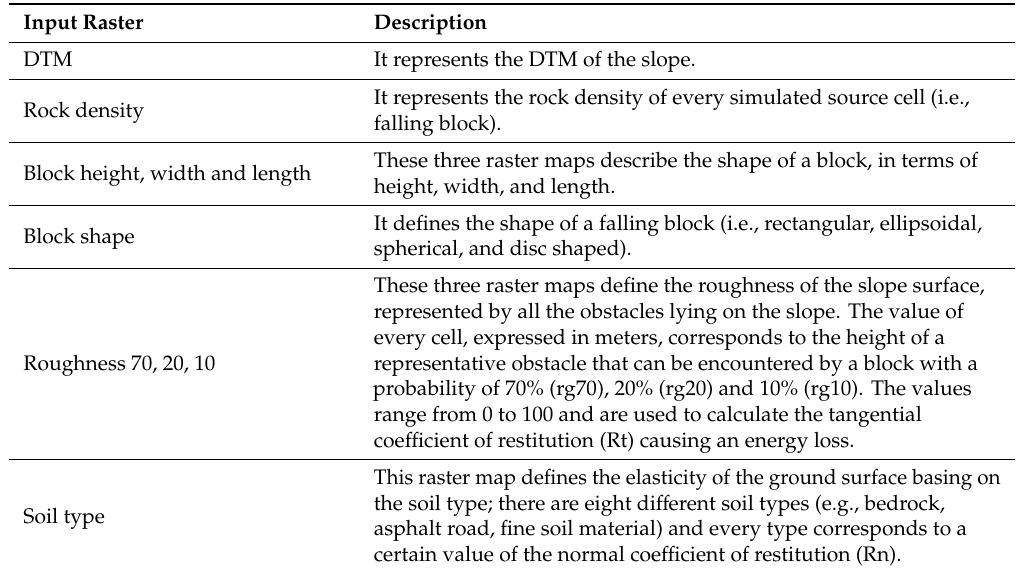
Table 1. Input raster maps necessary for using